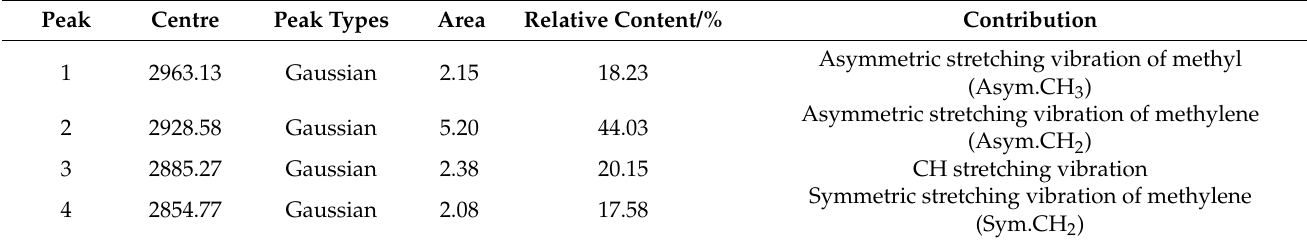
Table 9. Aliphatic hydrocarbon parameters of Kerjian coal.